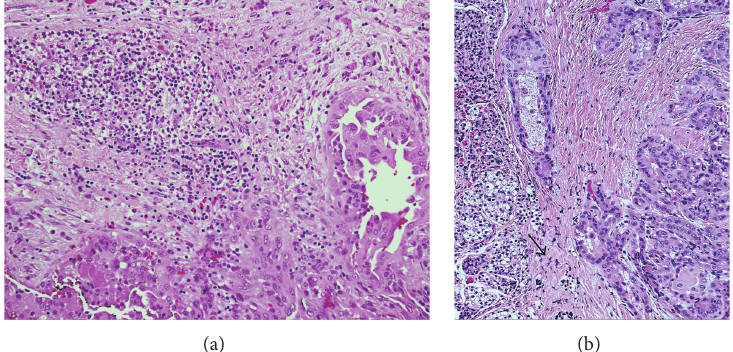
Figure 2: (a) Papillary thyroid carcinoma invading the parathyroid gland by a pattern A infiltration (Haematoxylin & Eosin stain, × 20). (b) Papillary thyroid carcinoma ( on the right ) invading a parathyroid gland by a pattern B infiltration. The parathyroid is located outside the thyroid capsule, which is separated from by an intervening fibrous capsule ( arrow ) (Haematoxylin & Eosin stain, ×